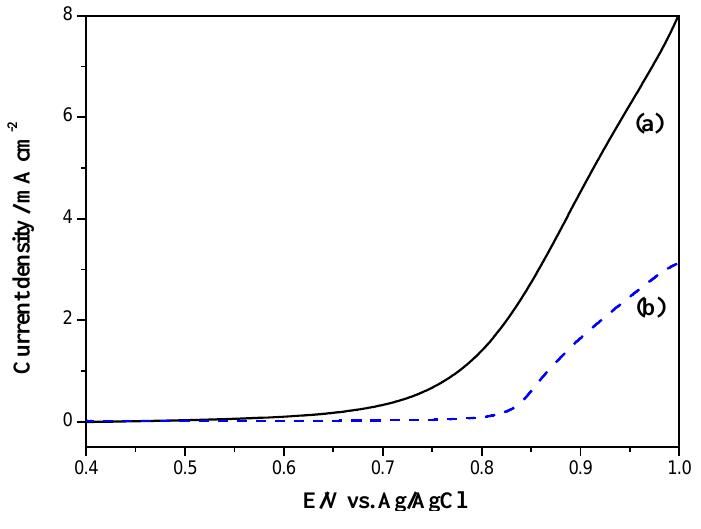
Figure 1. Anodic polarization curves of ( a ) 0.02 M EDOT and ( b ) 0.02 M ICA in ACN + 0.1 M LiClO 4 . Scanning rates: 50 mV s −1